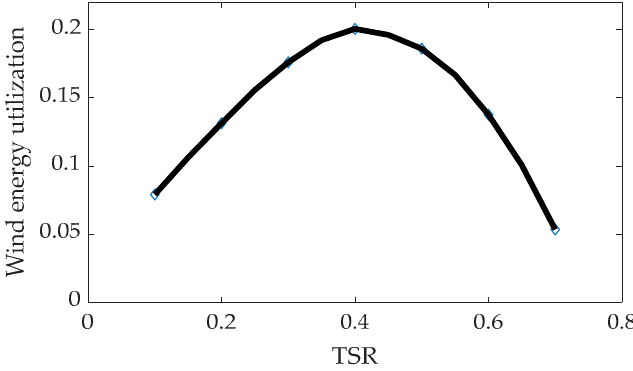
Figure 7. Tip speed ratio—wind energy utilization curve.